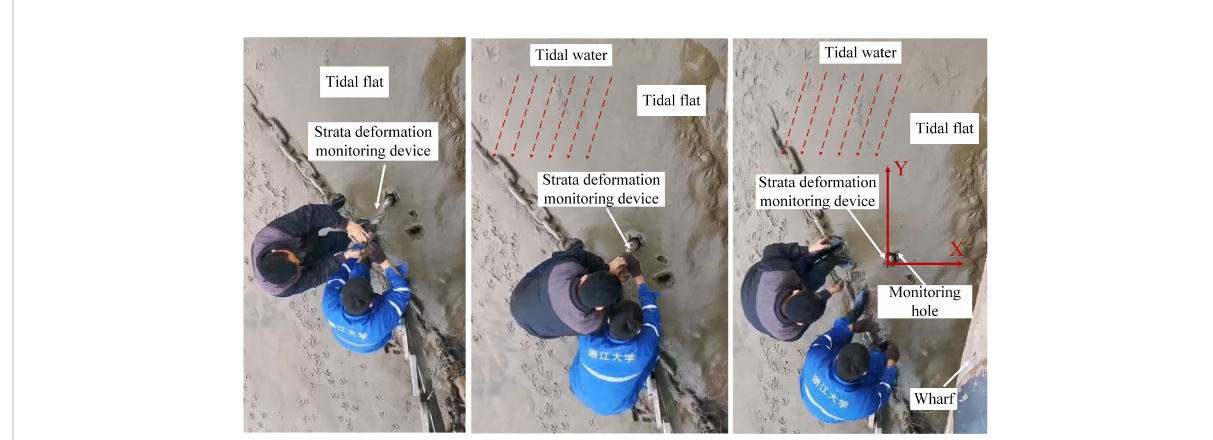
FIGURE 12 Deployment process of the monitoring instrument.